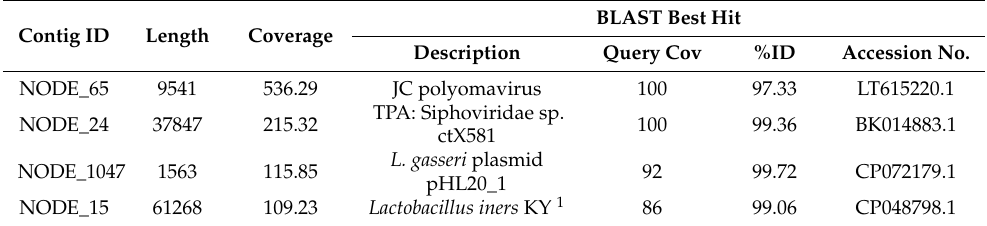
Table 2. Urinary microbiome VirSorter2 predictions exceeding the 99% threshold.